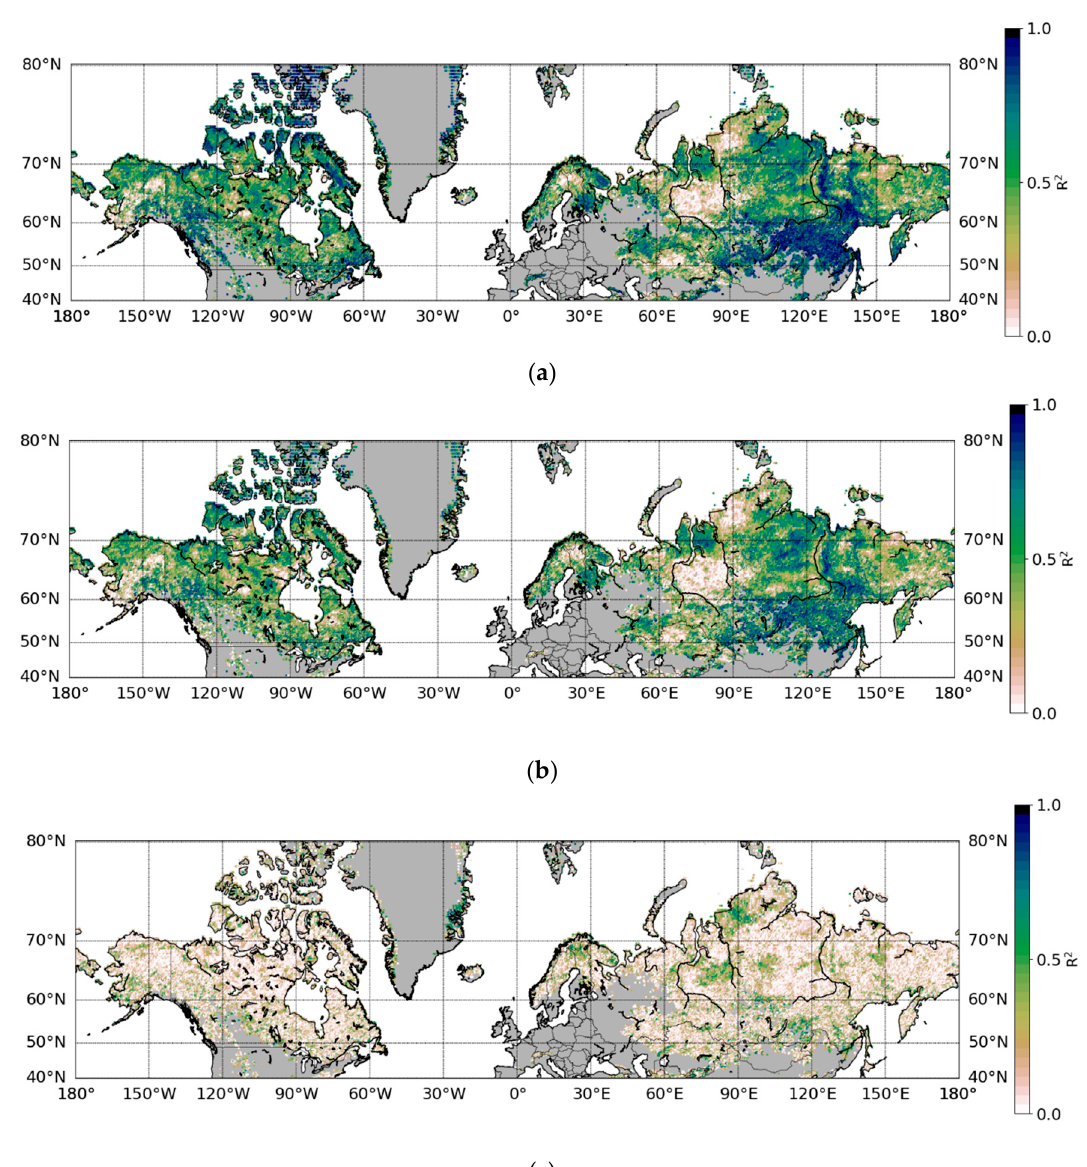
Figure 11. The rate of change observations for ( a ) start and ( b ) end day of melt. The dashed line shows the mean value of the observations for which R 2 is larger than 0.5.